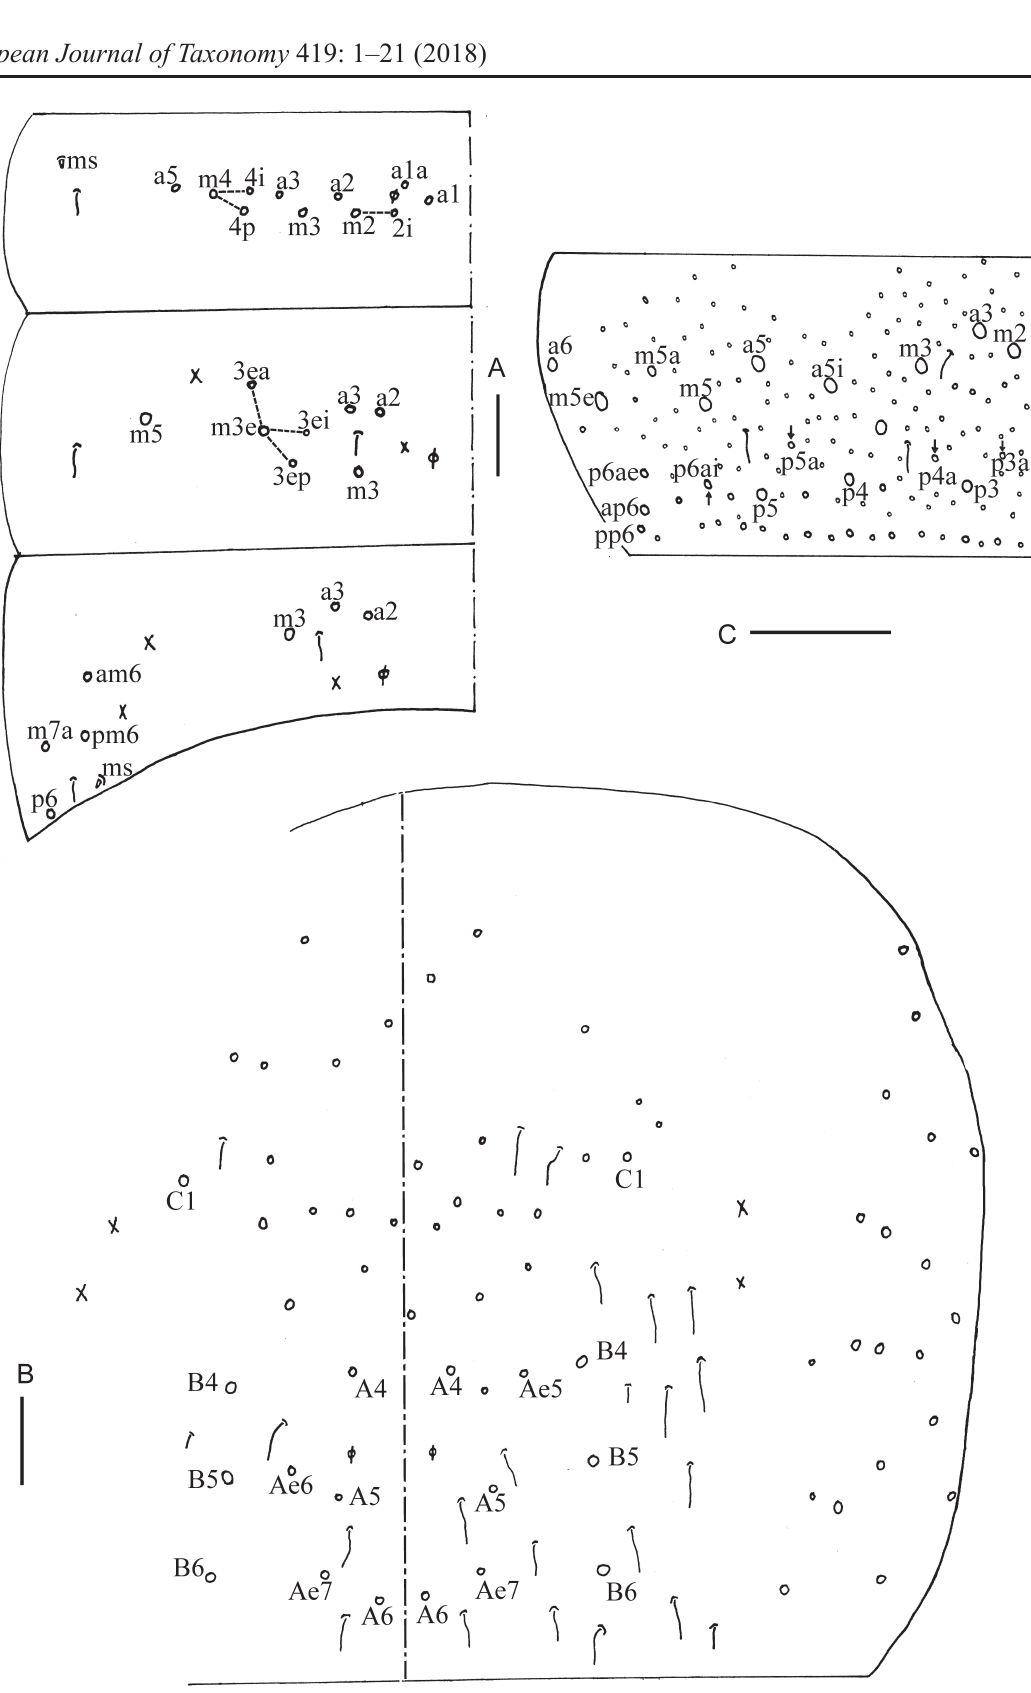
Fig. 4. Entomobrya leviseta sp. nov. A . Chaetotaxy of Abd. I−III. B . Chaetotaxy of Abd. IV. C . Chaetotaxy of Abd. V. Scale bars: A–C = 50